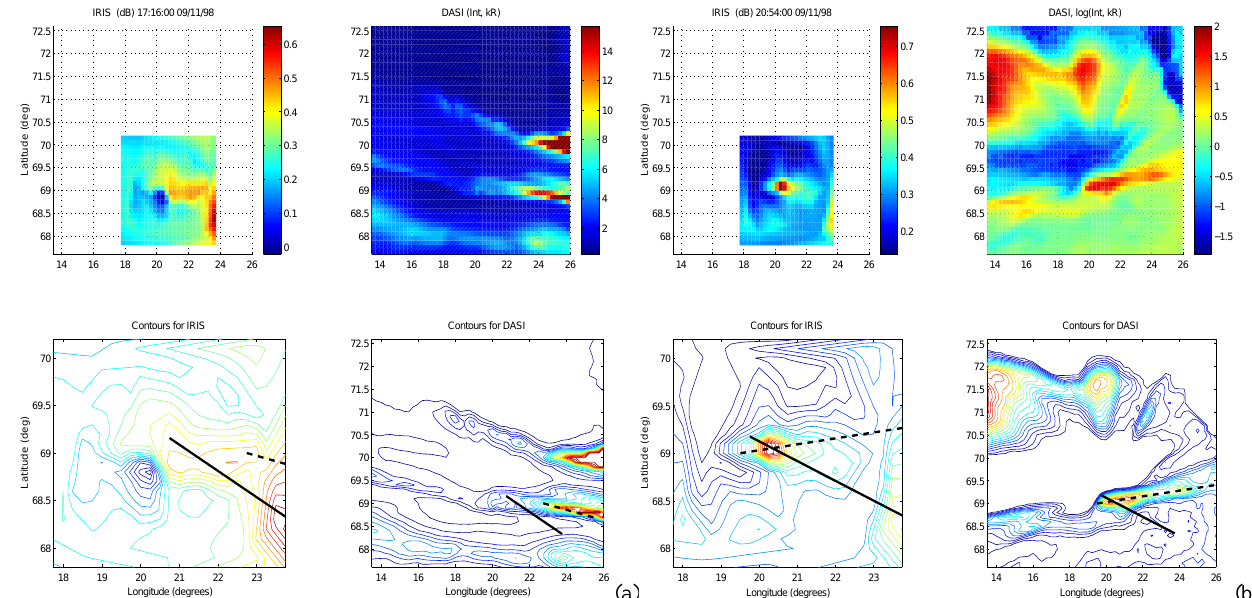
Fig. 6. Two cases of complex auroral forms observed on 9 November 1998, the colour scale for the absorption is in dB. (a) Arc-like structures at 17:16UT, the smaller field of view of IRIS only records the absorption patch associated with, and slightly south of, the middle optical arc. The scale for the optical emission is linear in kR. (b) Spiral shaped auroral form or distortion on the auroral arc at 20:54UT, the absorption region in the IRIS field of view is located slightly south of the lower “arm” of the optical feature. The logarithmic scale for the optical emission is just to obtain a better contrast. The full and dashed lines show, respectively, the elongation and alignment of the absorption region and the optical feature.